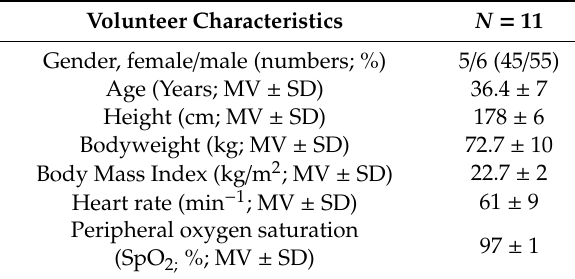
Table 1. Volunteer